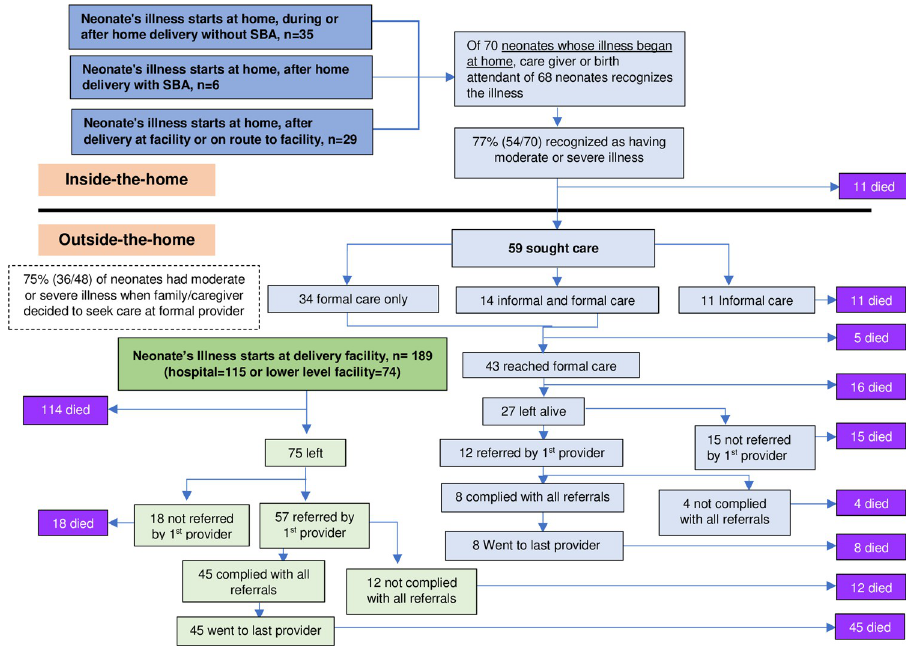
Fig 2. Care-seeking